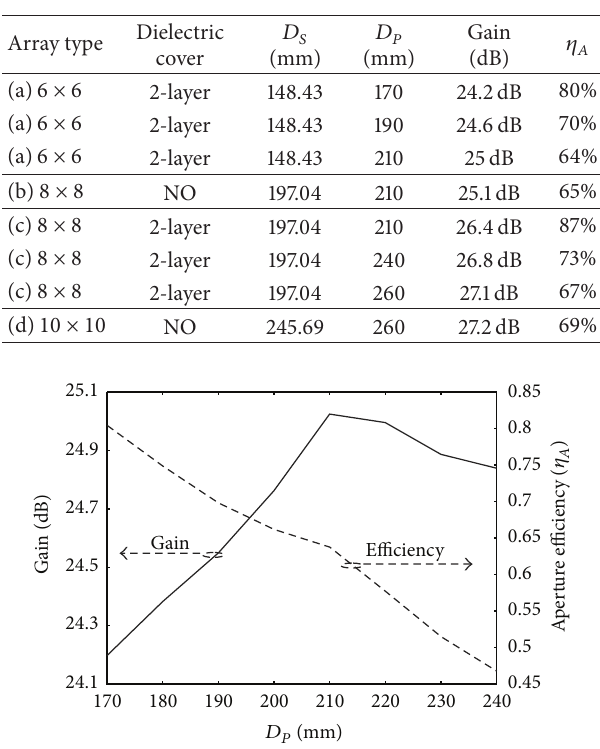
Table 1: Array gain and aperture efficiency.